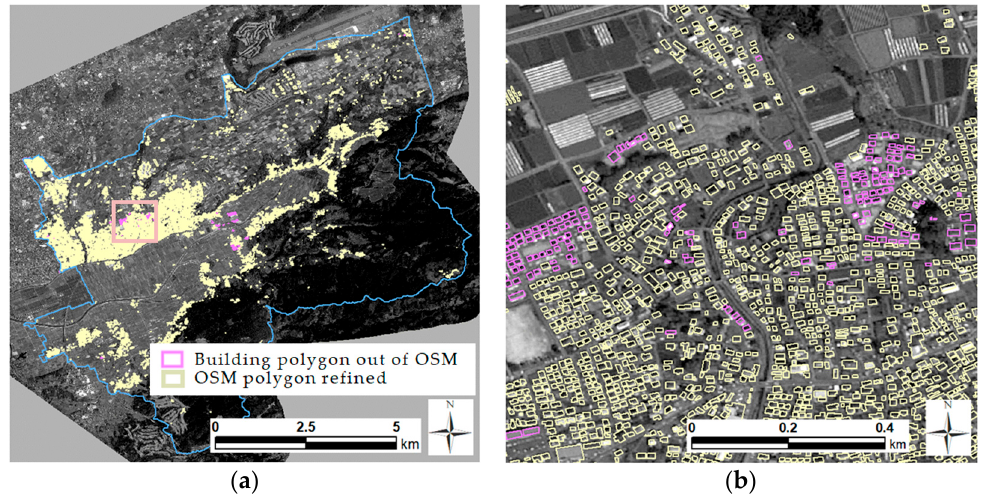
Figure 4. Buildings that were not recorded in the OSM data: ( a ) The whole view on Mashiki town and ( b ) zoomed-in view of the rectangle area.